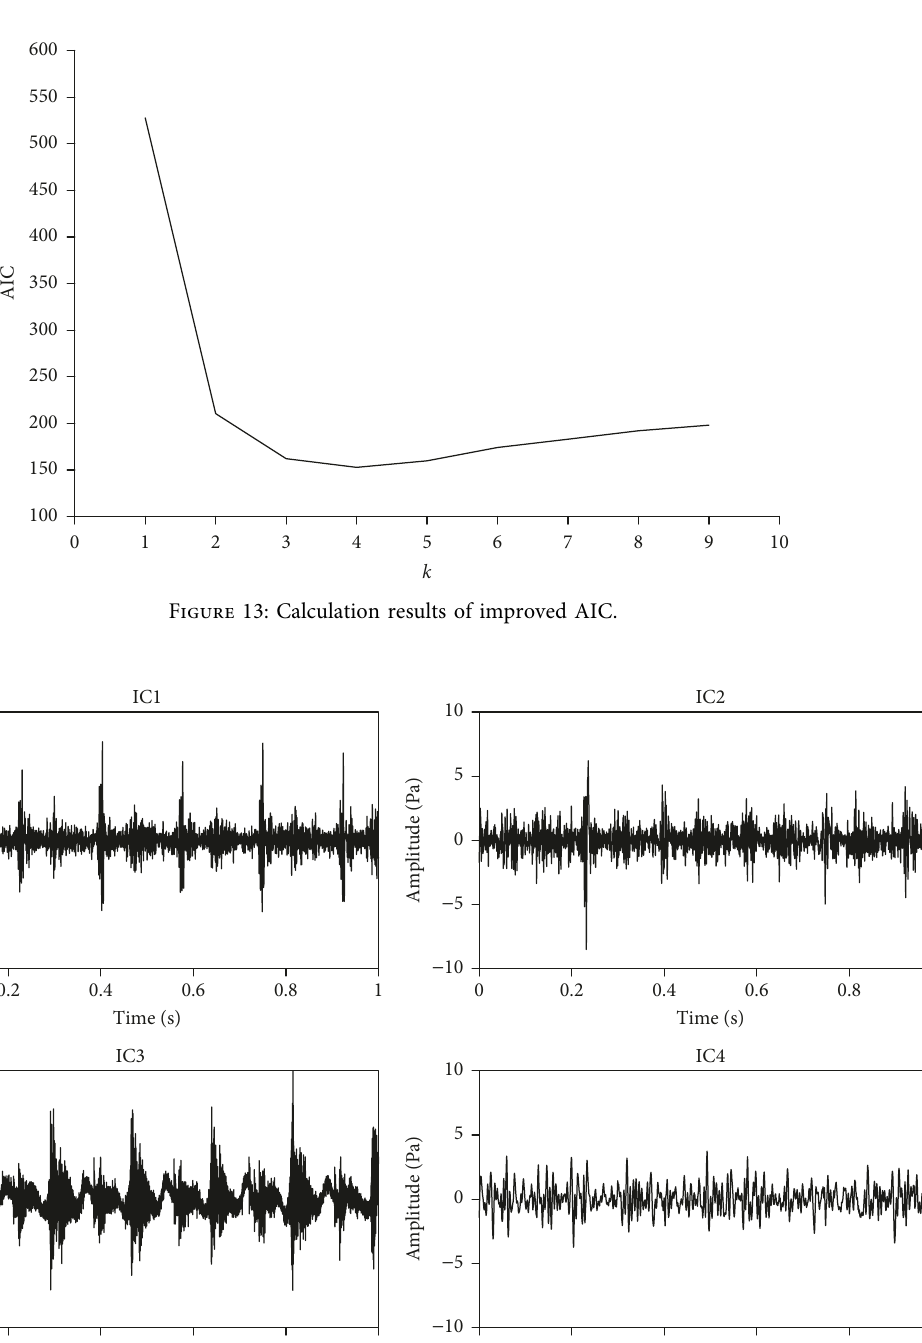
Figure 14: EEMD-AIC-FastICA separation